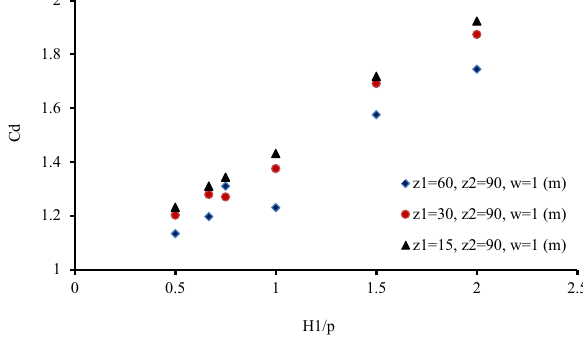
Fig. 7 Discharge coefficients for z heights